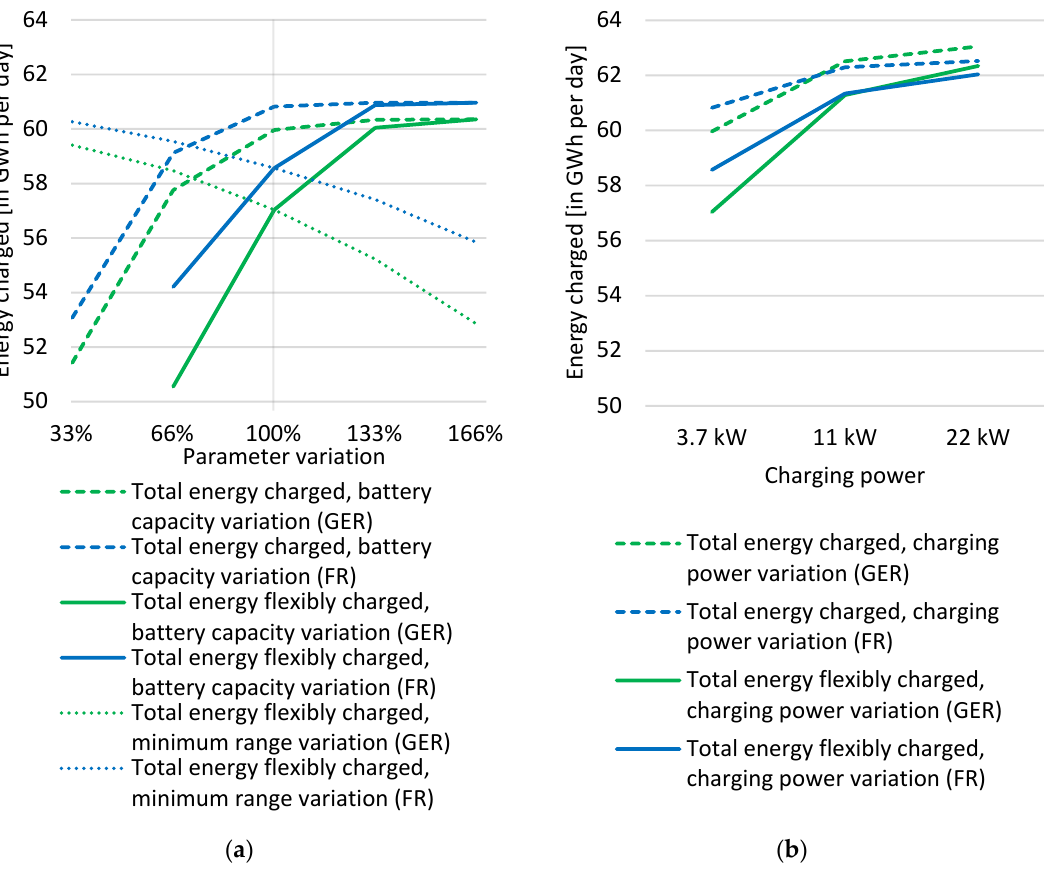
Figure 5. Sensitivity analysis concerning total energy charged and total energy flexibly charged, depending on ( a ) varying battery capacity, minimum range, and ( b ) charging power. Base case: charging with ( a ) 60 kWh battery capacity, 100 km minimum range, and ( b ) 3.7 kW.